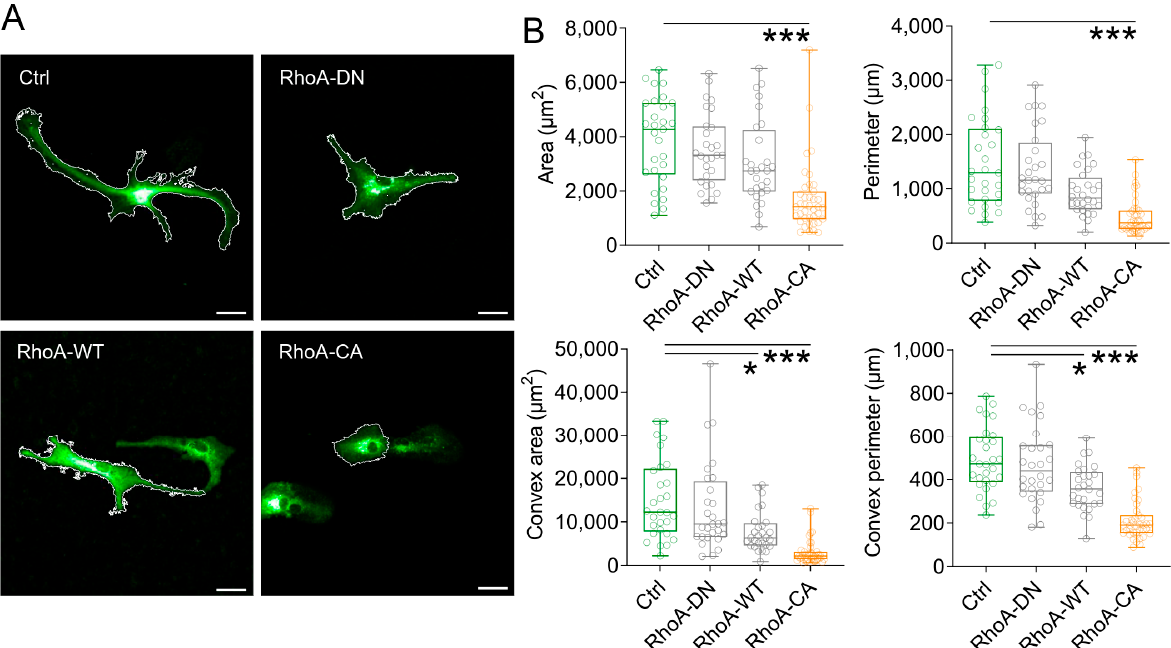
Figure 1. Activation of the RhoA pathway changes astrocyte morphology in vitro. ( A ) Increasing RhoA activity leads to retraction of astrocyte processes and a rounder cell shape. Representative images of astrocytes infected with rAAVs expressing variants of the small GTPase RhoA (dominant- negative, RhoA-DN; wildtype, RhoA-WT; constitutively active, RhoA-CA) tagged with mCherry for visualization or the far-red fluorescent protein TurboFP650 (Ctrl) under a mouse GFAP (mGFAP) promoter. White lines depict the region of interest (ROI) used for analysis (scale bars 20 μ m). ( B ) Evaluation of astrocyte morphology shows a reduction of astrocyte area, perimeter, convex area, and the perimeter of the convex area with increasing RhoA activity ( p < 0.001, Kruskal–Wallis test; Dunn’s multiple comparisons post hoc test, * p ≤ 0.05, *** p ≤ 0.001; cells from 4 individual cultures; n = 29, 28, 28 and 39 cells for Ctrl, RhoA-DN, RhoA-WT, and RhoA-CA, respectively). Box and Whisker plots: box indicates the 25th and 75th percentiles, the whiskers the minimum and max- imum values, the horizontal line in the box the median, and hollow circles on top the individual data points.